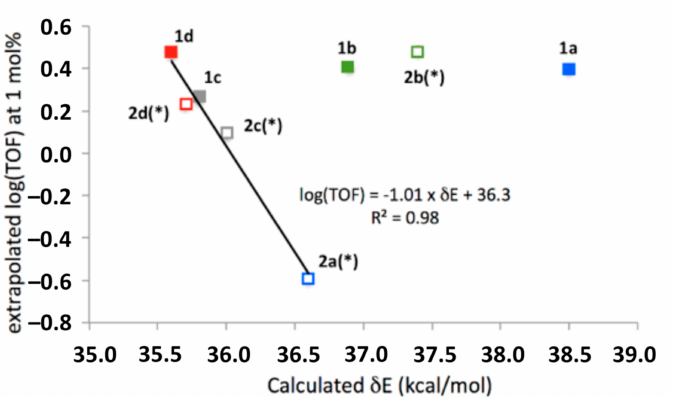
Figure 10. Relationship between low-concentration extrapolation of experimentally determined turnover frequencies and calculated energetic spans of each 2-HOBPO. The * symbol indicates that computational results were obtained for 2-HOBPOs with methyl substituents on phosphorus, and are being compared to experimental results obtained for 2-HOBPOs with ethyl substituents on